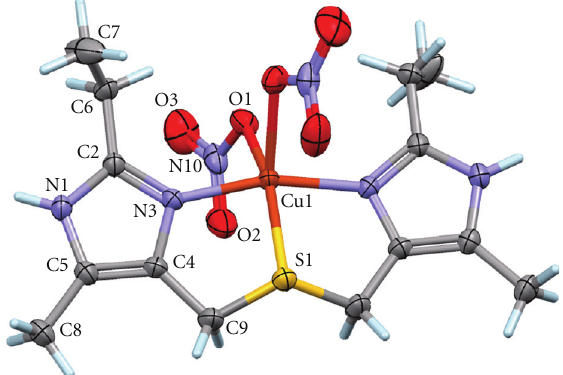
Figure 3: ORTEP projection [16] of the complex [Cu( bemims )(NO 3 ) 2 ] with displacement ellipsoids for non-H atoms at the 30% probability level. The labeling scheme is given for the asymmetric unit, while unlabelled atoms are generated by symmetry 1- x , y , 1/2- z . For clarity, a single disordered site for S1 is